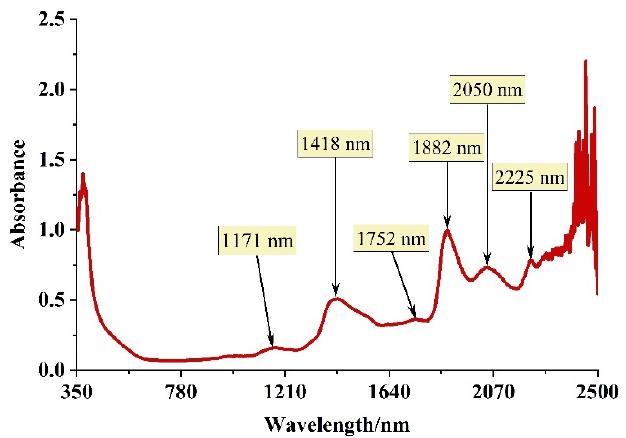
Figure 3. The raw Vis-NIR spectra of the increment core sample.